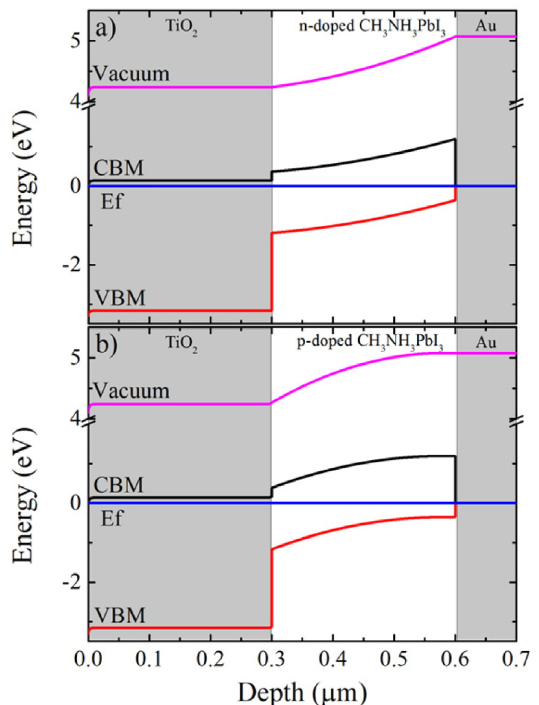
Fig. 2. Static band diagram of (a) n-doped and (b) p-doped CH 3 NH 3 PbI 3 based HTM-free PSCs.